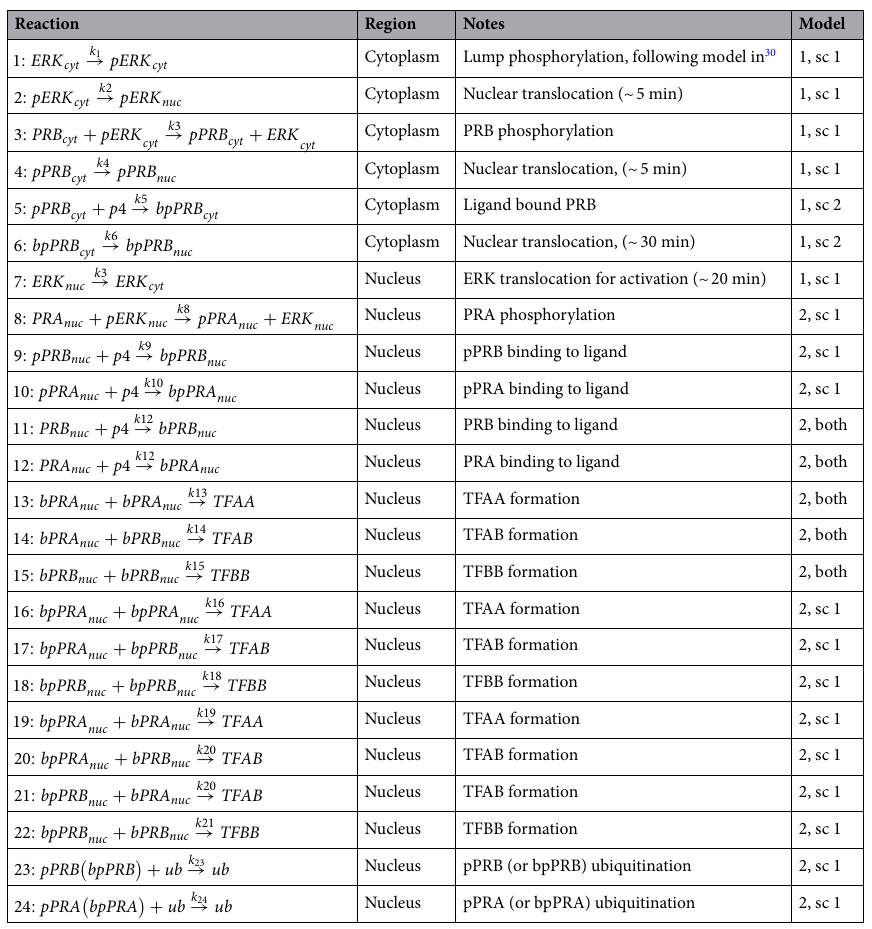
Table 3. Reactions considered in all models (‘sc’ indicates